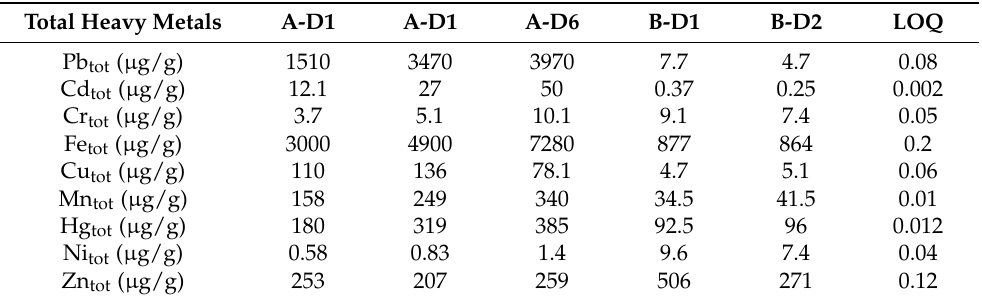
Table 2. Total concentrations ( µ g/g dust) of Pb, Cd, Cr, Fe, Cu, Mn, Hg, Ni and Zn in three dusts and the LOQ (after digestion).